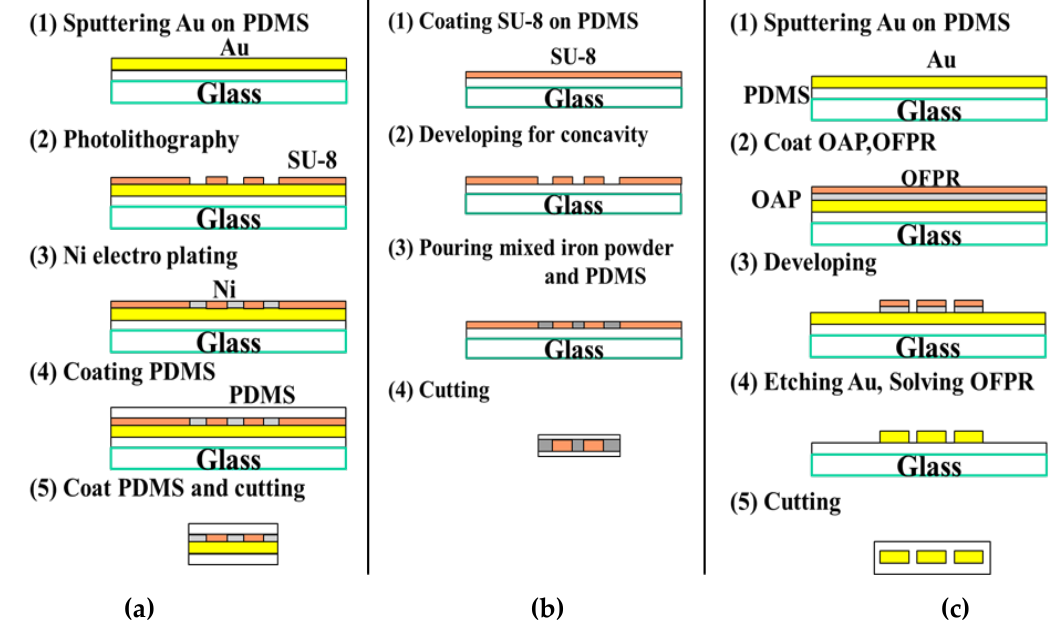
Figure 3. Detailed magnetic tag creation process. ( a ) Nickel plating is selectively performed by forming SU-8 insulation in the conducting part made by gold sputtering, and a pattern carrying information is produced. ( b ) Mixture of PDMS and iron powder is poured into the depression of SU-8 made by photolithography. ( c ) Tag-type photolithography is applied to gold sputtered on a substrate. Exposed gold is dissolved by immersion in the gold etchant, leaving a tag-shaped gold thin film.